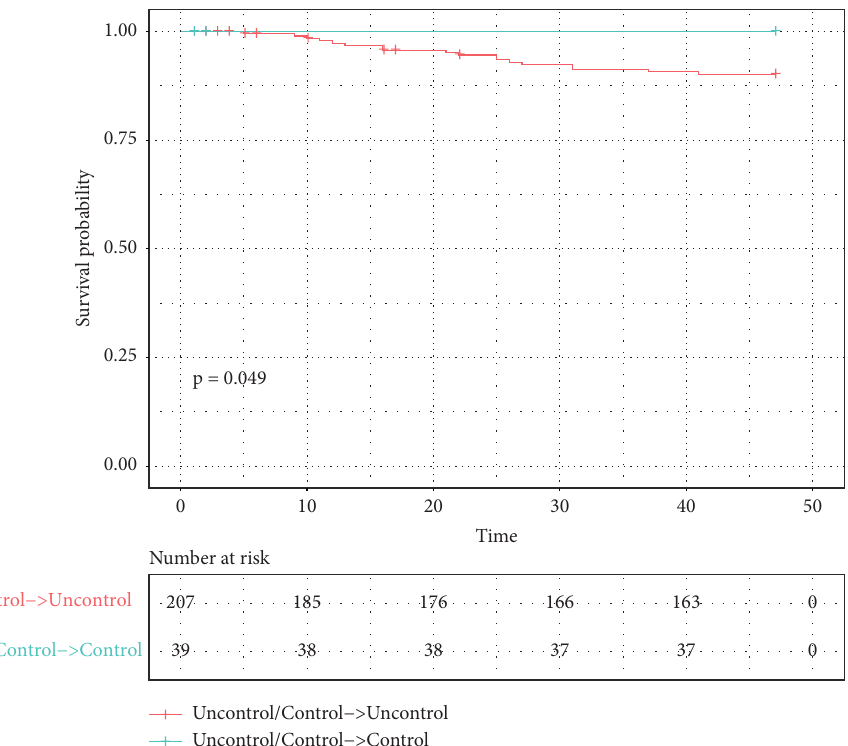
Figure 3: Kaplan–Meier curve for all-cause mortality in patients with and without two to three risk factors’ control at final